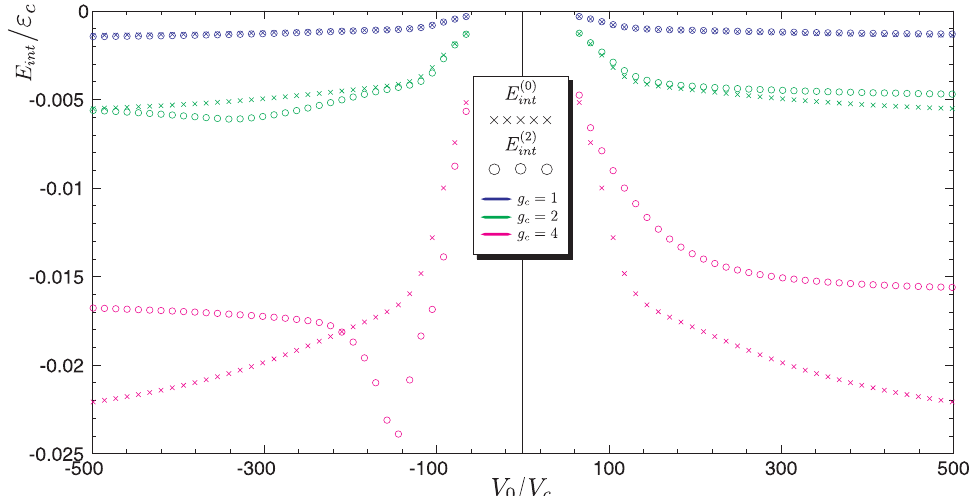
Figure 5. Interaction energy E int as the function of impurity potential V 0 . × —the results obtained for the interaction energy in the first iteration step (see the blue dashed line (Figure 6)). Solutions marked with a circles correspond to E int in the last iteration step of the self-reconciliation procedure. Colors denote different values of the constant g c